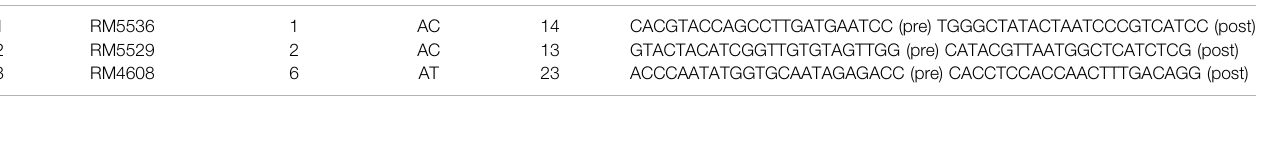
TABLE7| ThistablesshowsthenumberofQTLsidenti fi edforthecontentofiron(Fe),phosphorous(P),calcium(Ca),strontium(Sr),chromium(Cr),zinc(Zn)andmagnesium (Mg)inthebrownriceofTowadaNILs.Italsoshowsthelocationonchromosome,intervalsofmarkers,markerpositionintermsofcenti-morgen(cM),thelogofoddratio (LOD) and percentage of phenotypic difference.